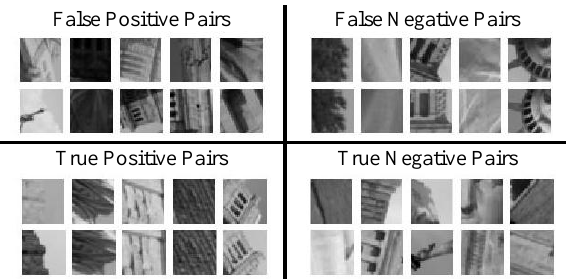
Fig. 7. Some cascaded classification result tested on Liberty